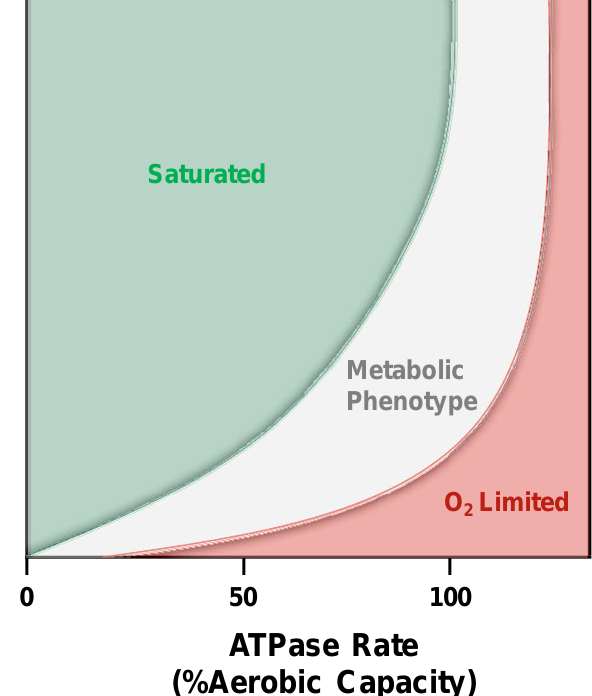
Figure 5. Theoretical description of the critical point for limitations to mitochondrial respiration. Modified from Connett et al. [178] this qualitatively shows the limitations to mitochondrial respiration. Axes are deliberately not defined, and the colored zones are conceptual rather than quantitatively meaningful. The green “saturated” zone represents where oxygen is in excess and reductions at low workloads will not a ff ect mitochondrial function. If oxygen supply is decreased into the “metabolic phenotype” zone, mitochondrial respiration will not decline but at the expense of increased oxygen extraction and decreased phosphate potential. Finally, in the extreme or “O 2 limited” zone, oxygen supply will limit mitochondrial respiration and result in a first-order dependence on oxygen that could be misinterpreted as mitochondrial dysfunction.